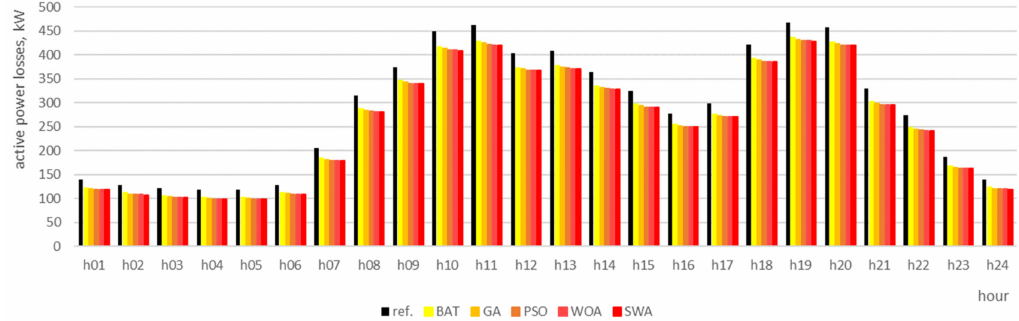
Figure 16. Hourly active power losses in the IEEE 33-bus system, for each algorithm. Table 8. Hourly and total active power losses in the IEEE 33-bus system, in kW, for each